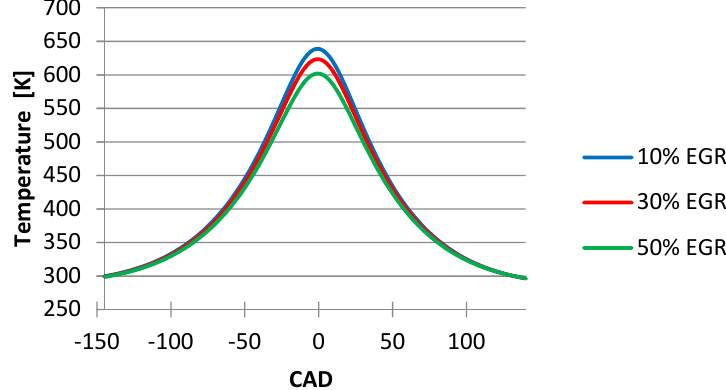
Figure 4. EGR ratio influence on temperature inside the cylinder.